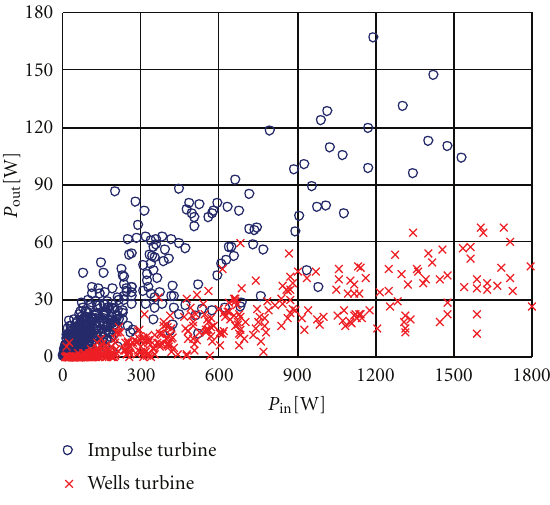
Figure 18: Comparison of average